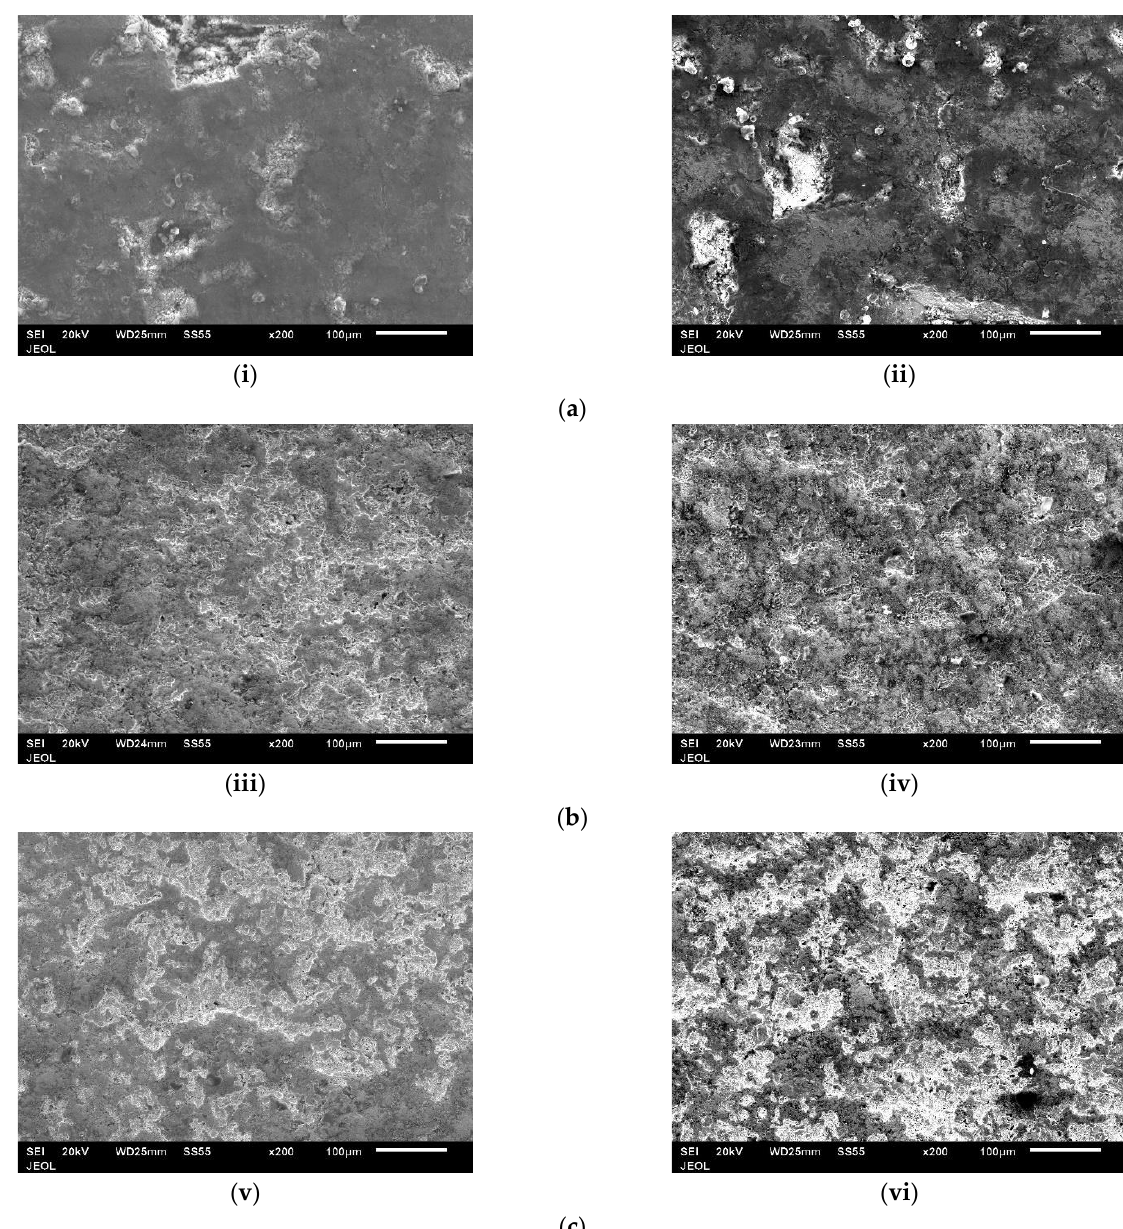
Figure 18. Comparison between eroded surfaces ( a ) Substrate, ( b ) WC-12Co and ( c ) WC-10Co-4Cr. at 2 h: ( i , iii , v ) and 3 h: ( ii , iv , vi) .